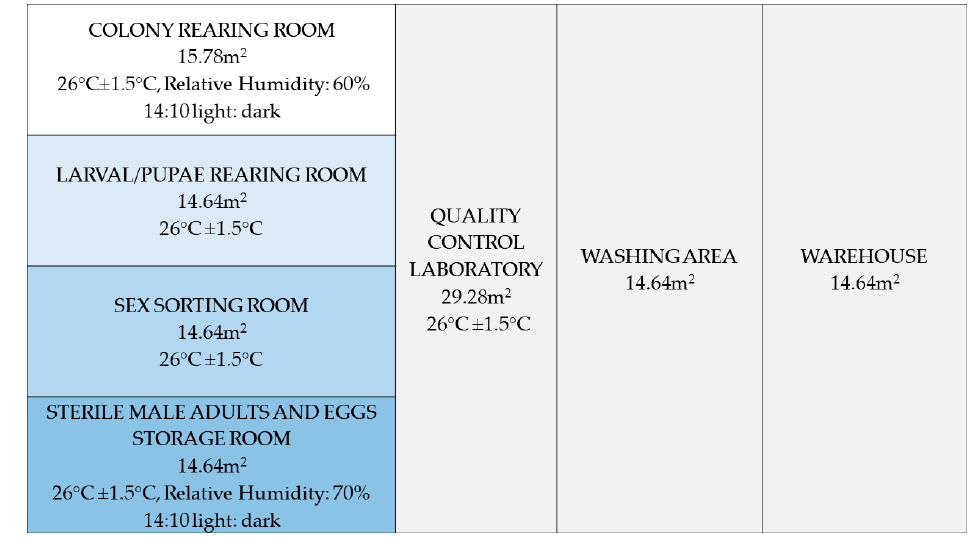
Figure 1. Layout of the Valencia medium-scale rearing